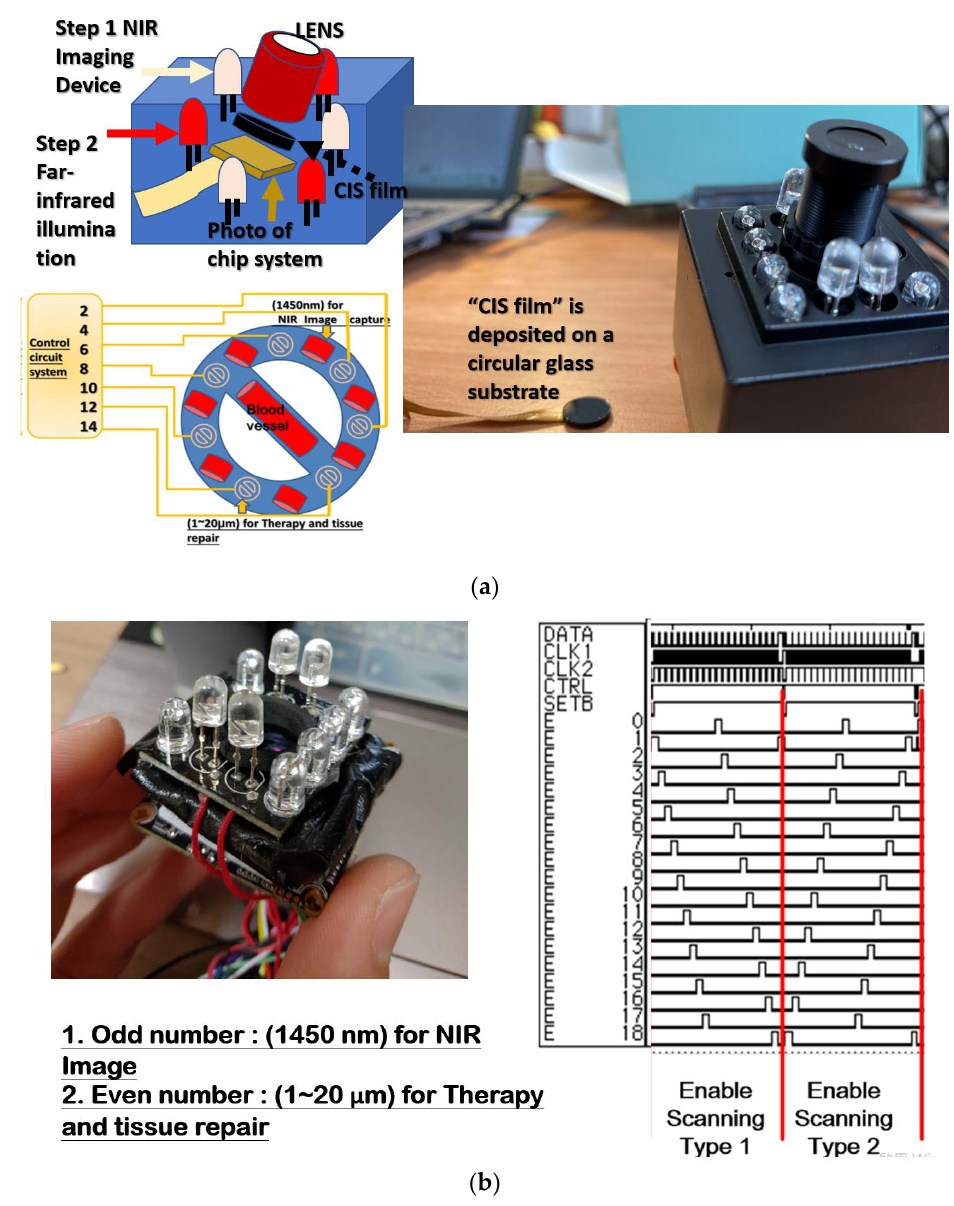
Figure 3. ( a ) The image of the CuIn x Se 2 (CIS ) system. ( b ) in the large far-infrared array, odd and even channel groups are turned on at different times to avoid them interfering with each other.